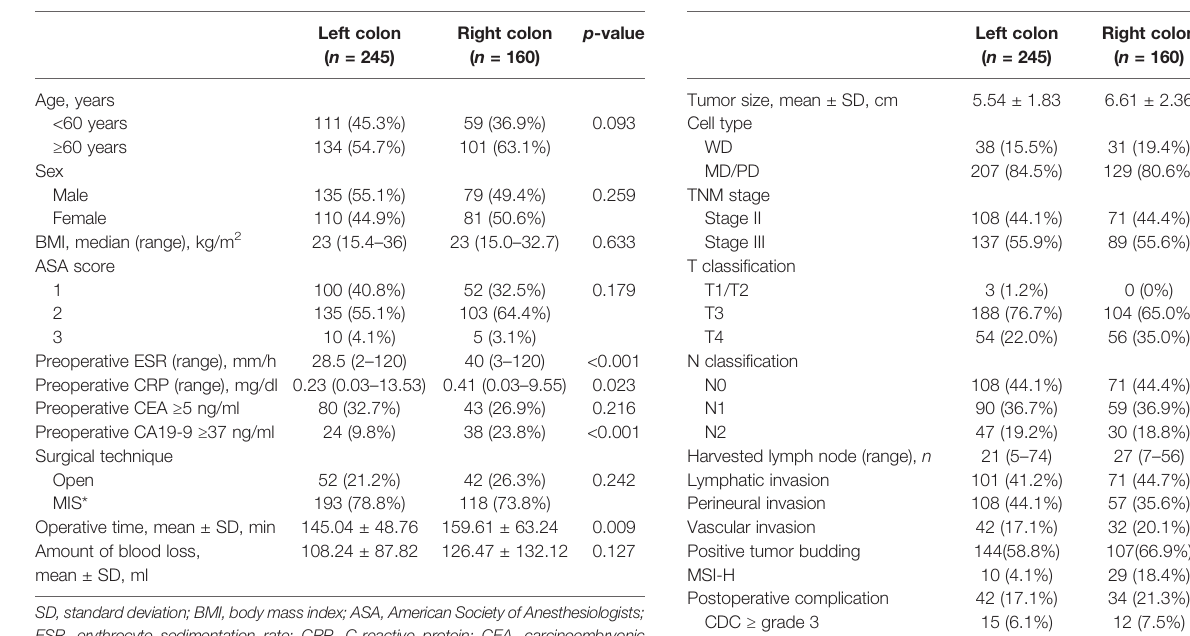
TABLE 3 | Baseline characteristics of incomplete obstructive colon cancer (IOCC) by tumor location.